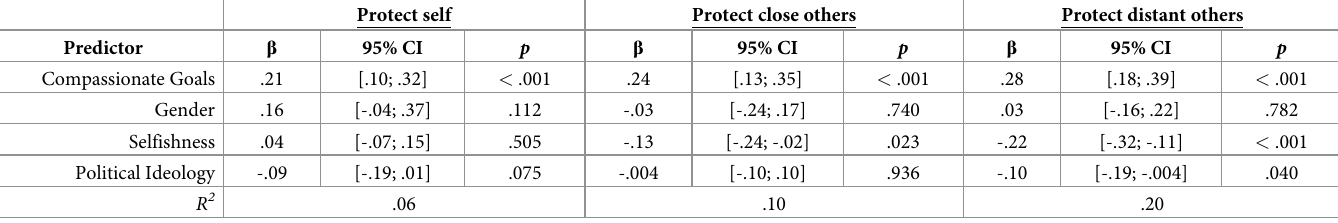
Table 3. Coefficients from multiple regression models predicting reasons for COVID-19 health behaviors in Study 1. Protect self Protect close